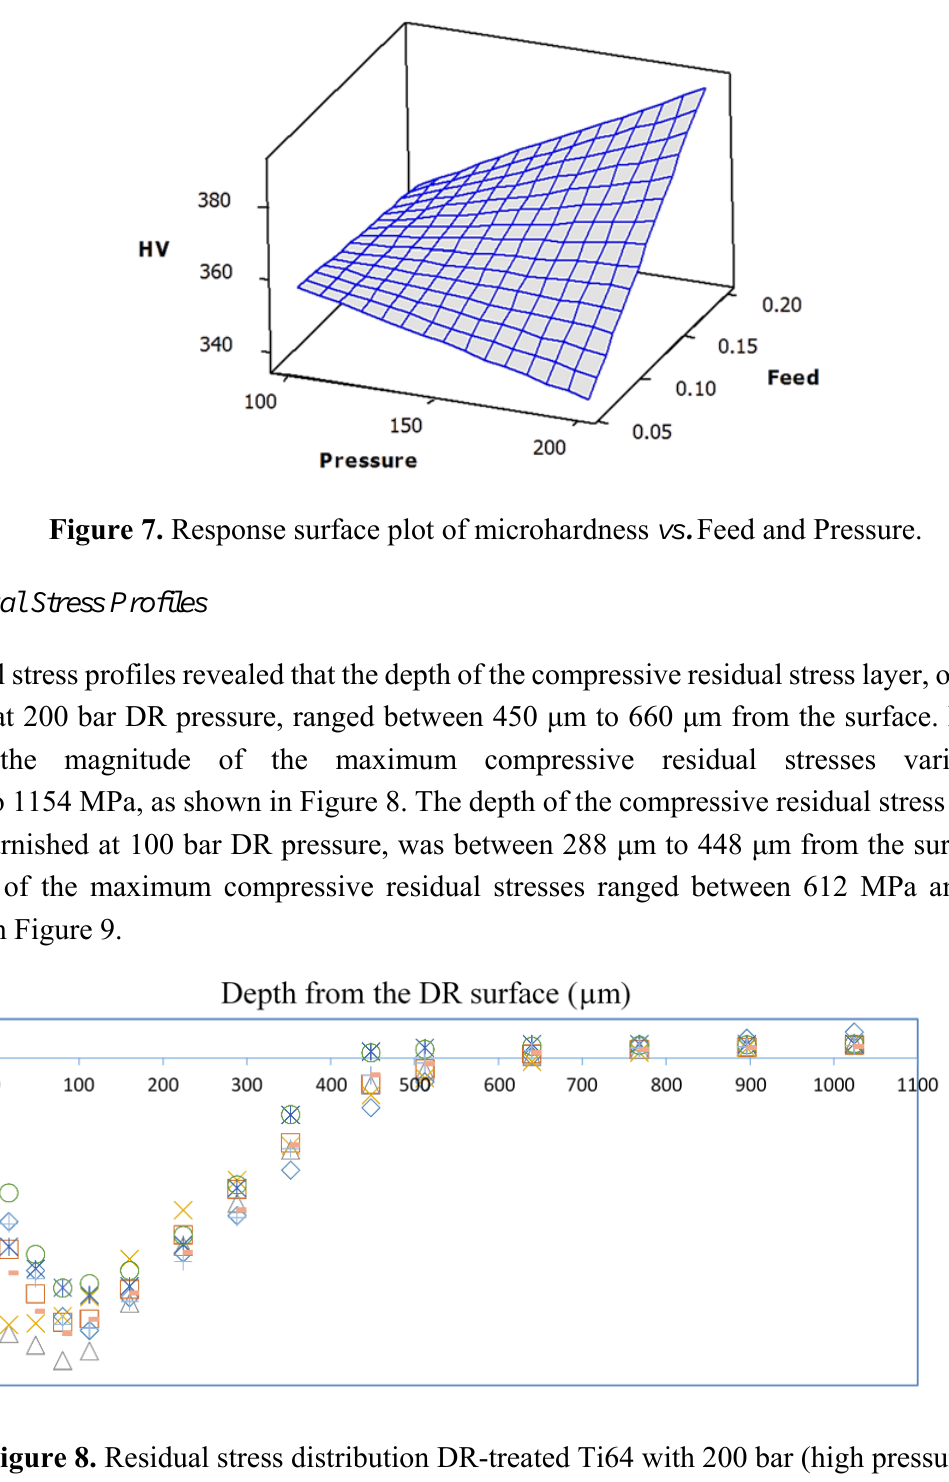
Figure 8. Residual stress distribution DR-treated Ti64 with 200 bar (high